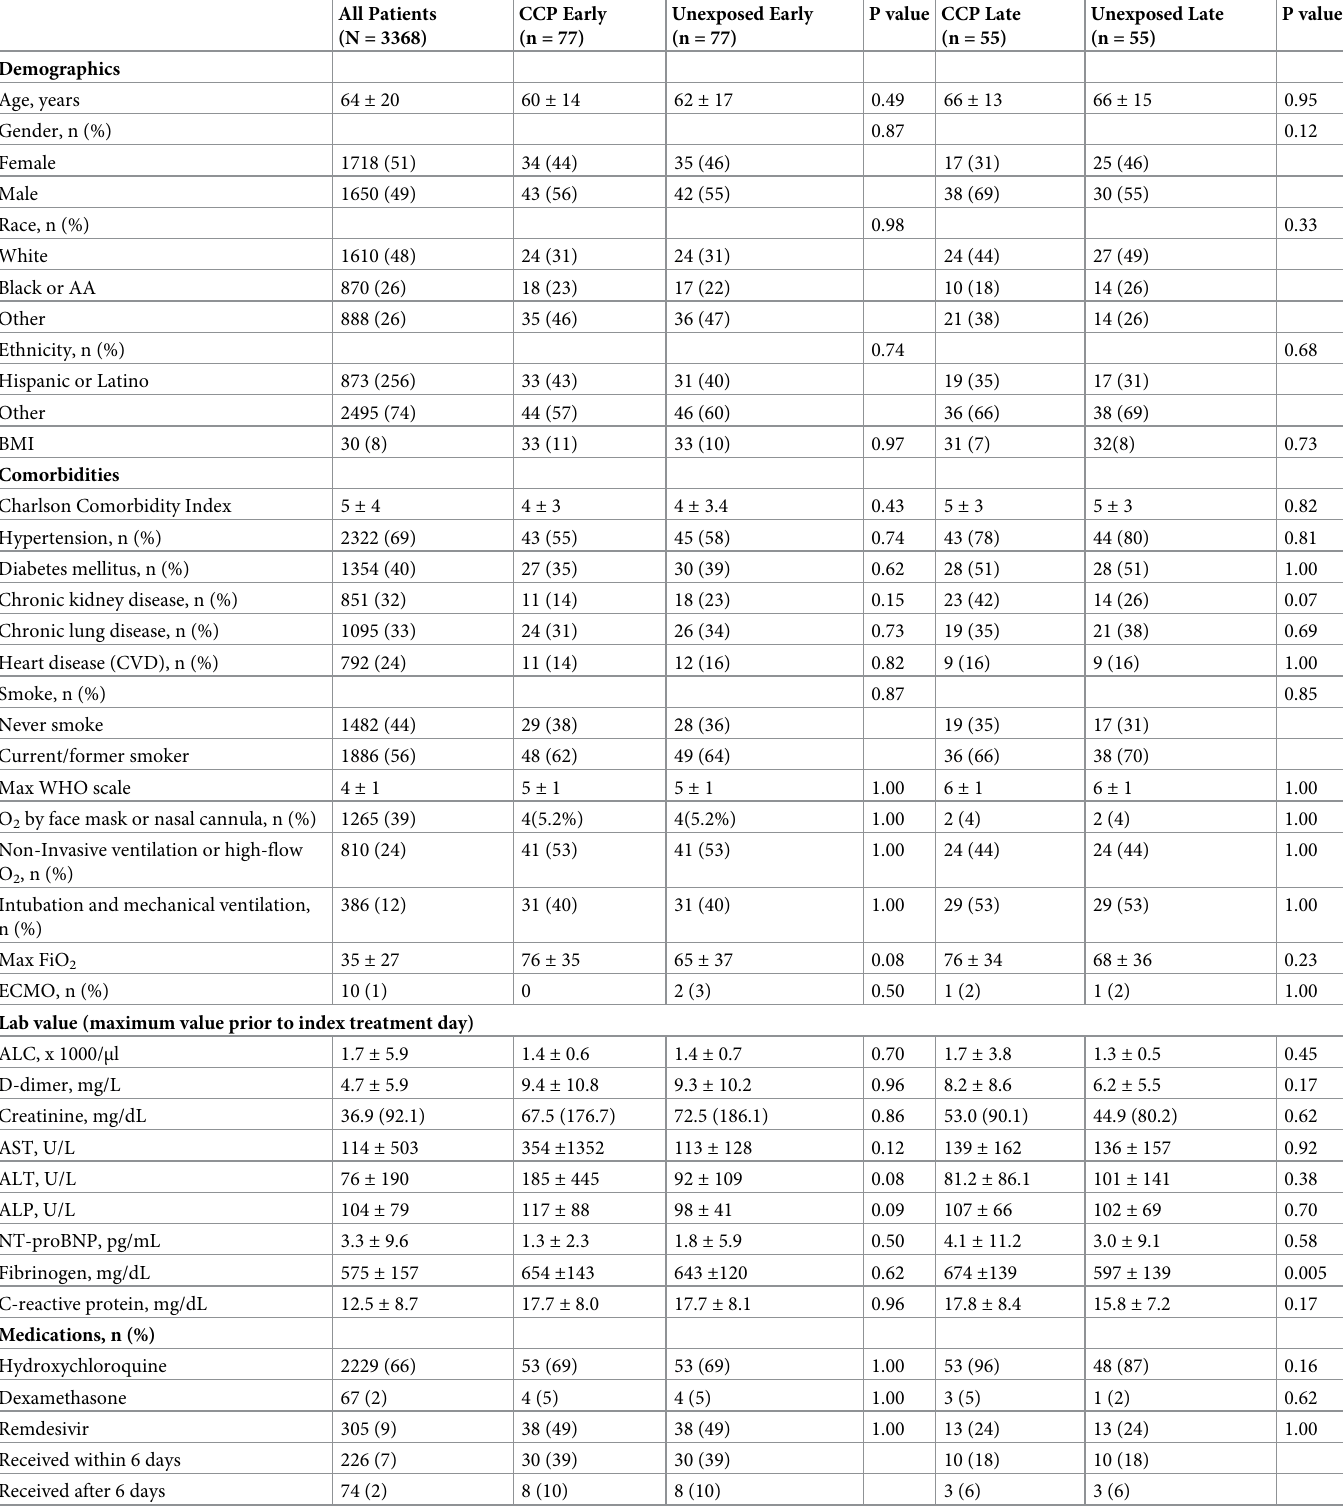
Table 1. Baseline demographic characteristics and clinical